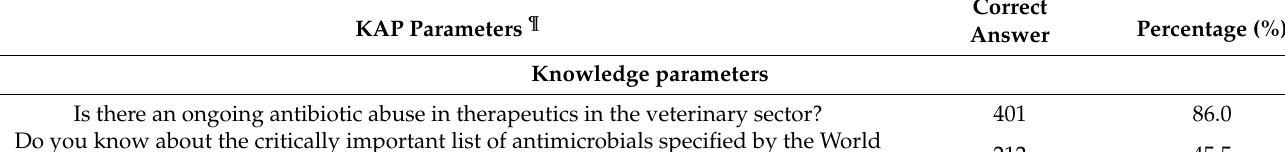
Table 2. Knowledge, attitude, and practices (KAP) of veterinarians regarding antibiotic use and resistance. KAP Parameters ¶